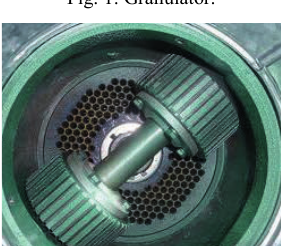
Fig. 1. Granulator.